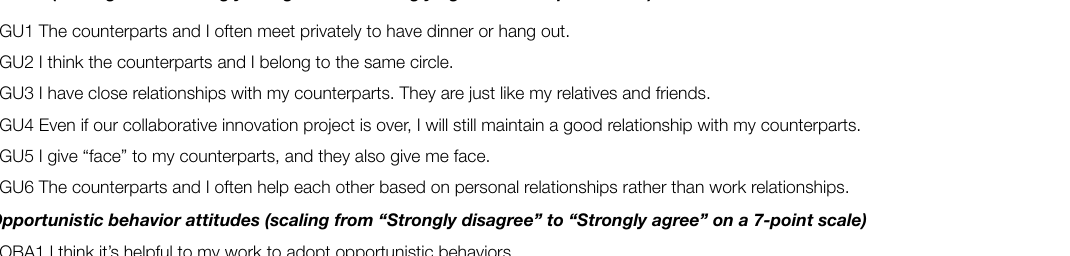
TABLE 2 | Measurement items of each construct. Guanxi (scaling from “Strongly disagree” to “Strongly agree” on a 7-point